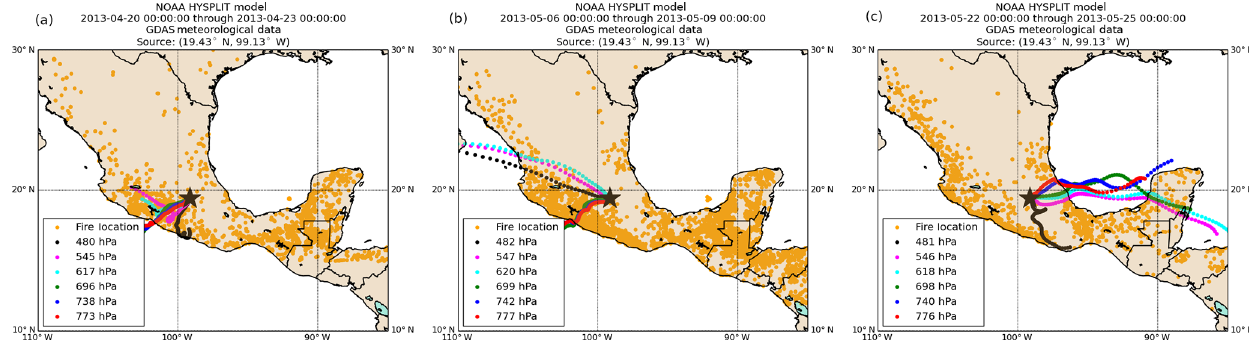
Figure 4. HYSPLIT back trajectories and FIRMS fire locations in Mexico for 9 May (a) , 25 May (b) and 23 April (c) . Fire maps include fires from the selected dates and the 2 previous days. Pressures on back-trajectory plots refer to level at which the back trajectory was